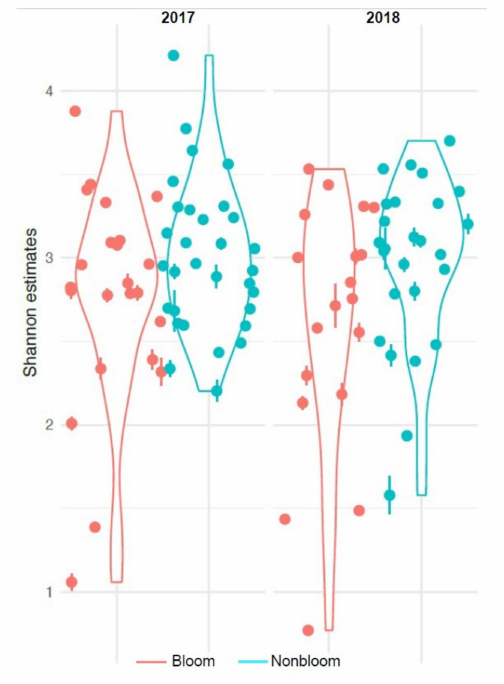
Figure 7. Shannon diversity index of 2017 and 2018 sample sets.